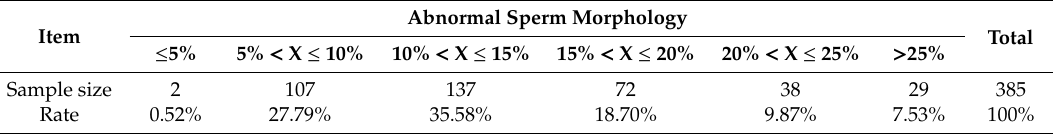
Table 2. Data distribution of mean abnormal sperm morphology at three months in experimental boars.